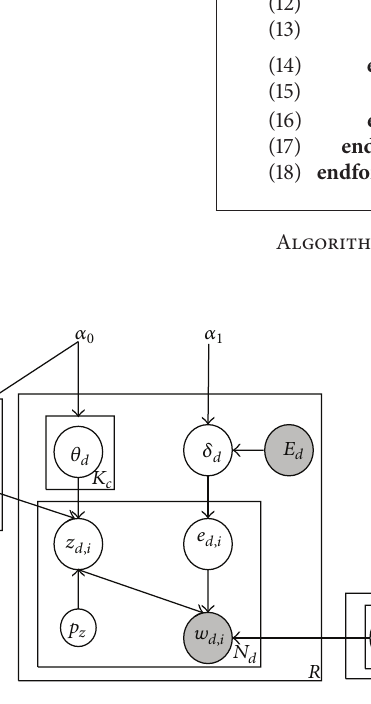
Figure 1: A graphical representation of